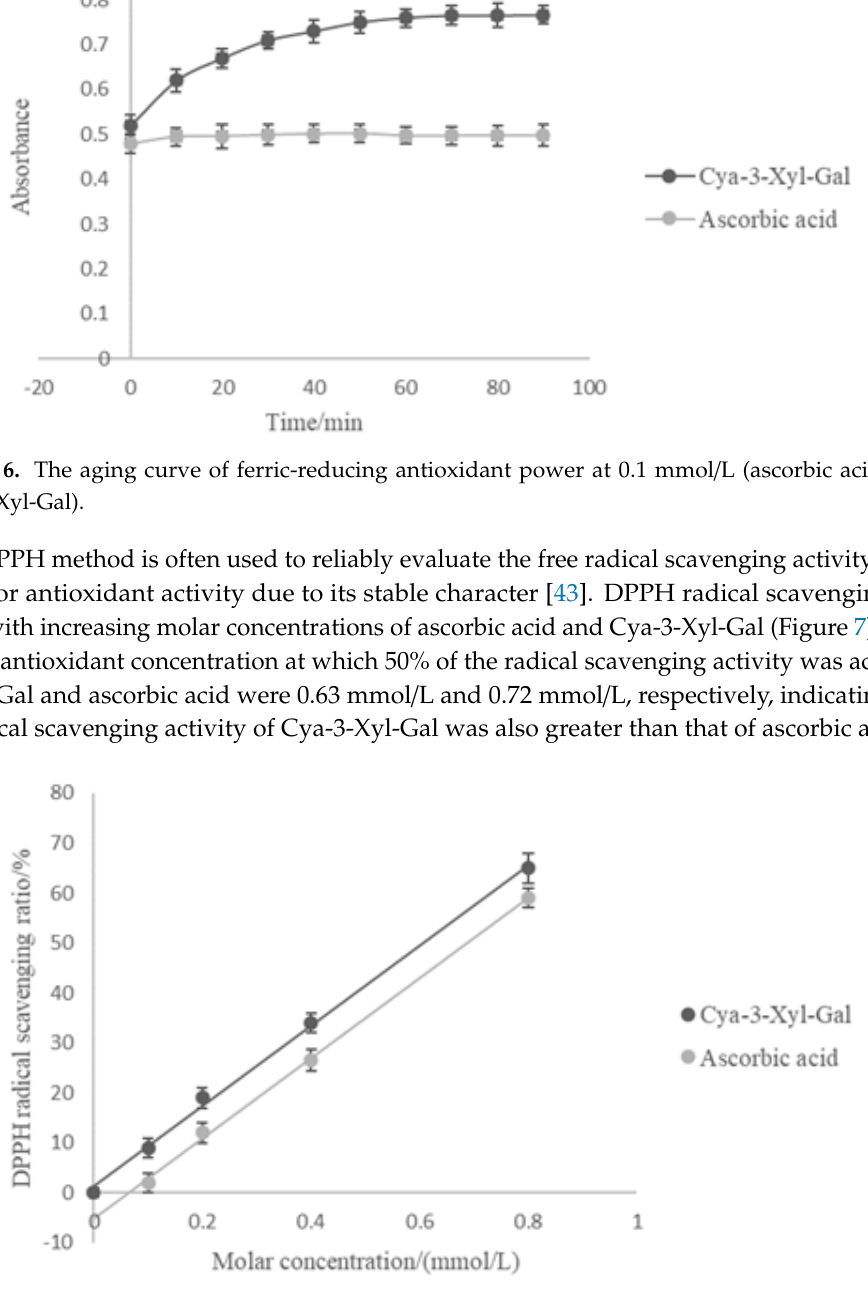
Figure 7. Relationship between the molar concentration of ascorbic acid and Cya-3-Xyl-Gal and DPPH radical scavenging exhaustion for the determination of the IC 50 values.